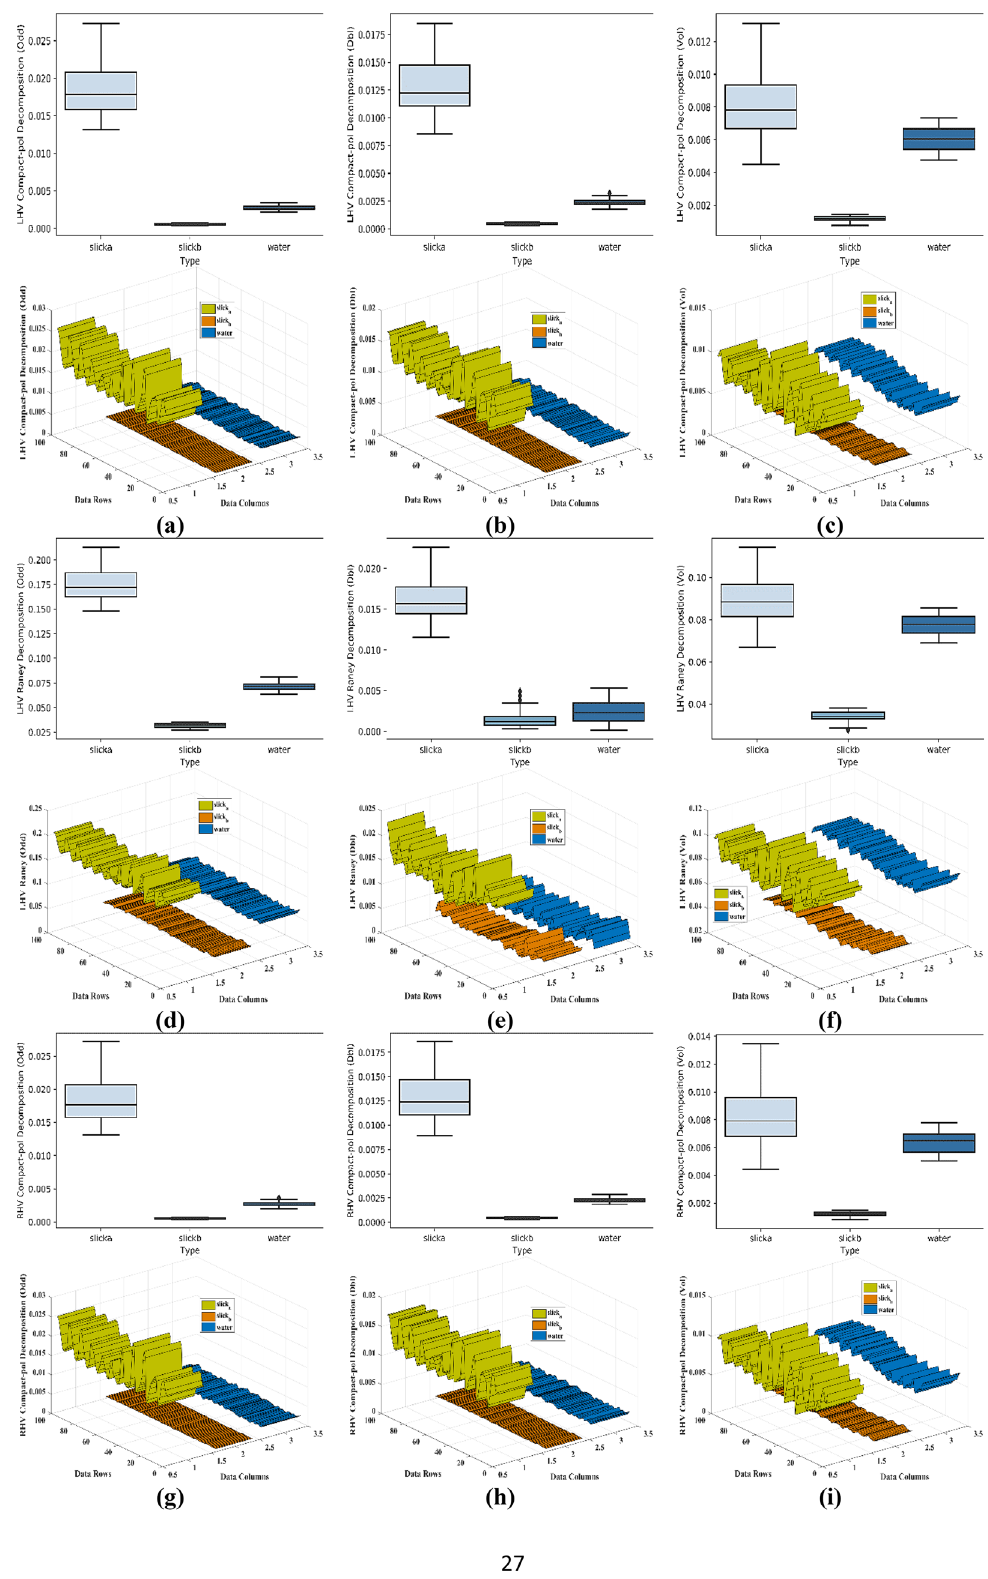
Figure 13. Extracted Box-whiskers and respective separability plots from second data for slicka, slickb and water regions for ( a – c ) LHV Compact-pol Decomposition, ( d – f ) LHV Raney Decomposition, ( g – i ) RHV Compact-pol Decomposition and, ( j – l ) Coherency